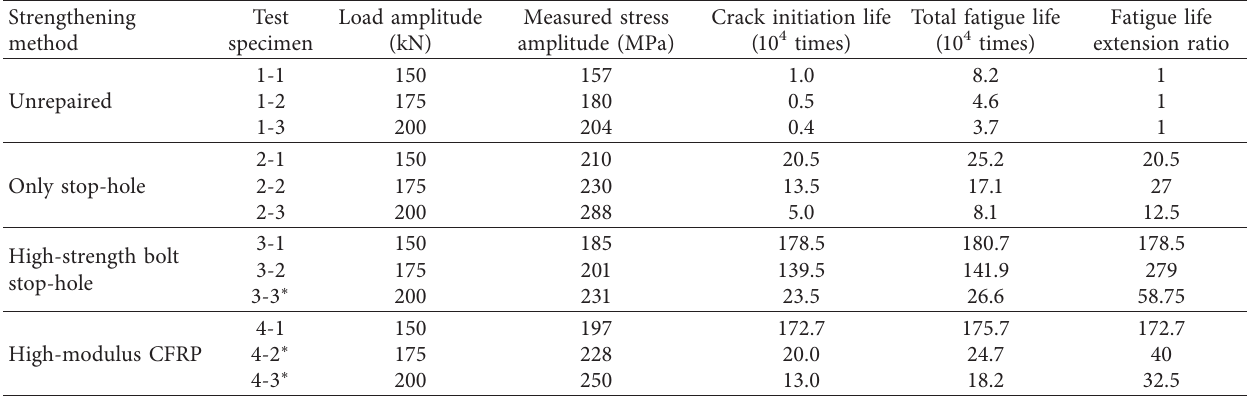
Figure 20: CFRP debonding of Group 4 during fatigue test. Table 4: Fatigue test results of